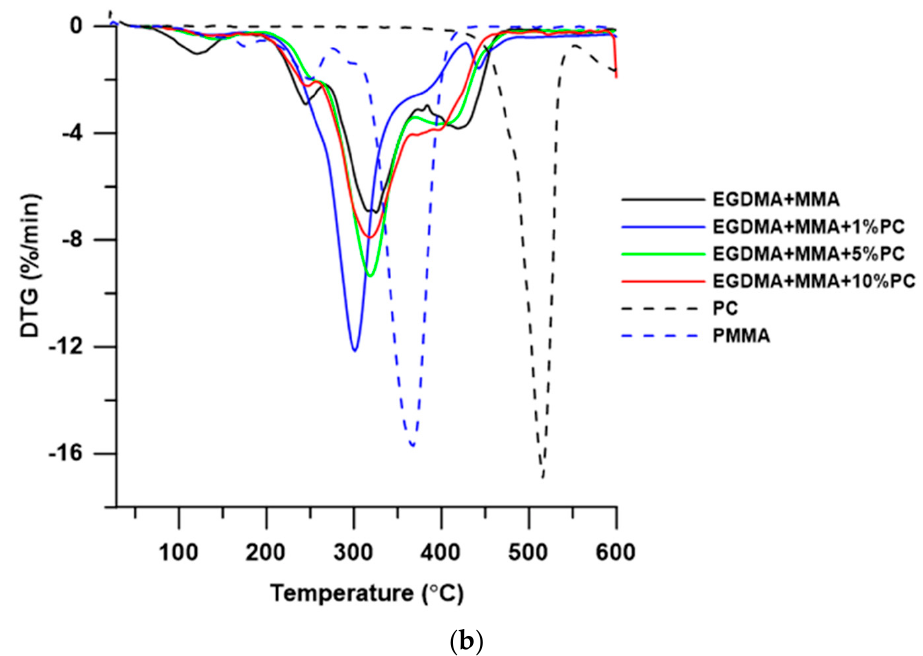
Figure 6. TG ( a ) and DTG ( b ) curves of EGDMA + MMA-based blends.